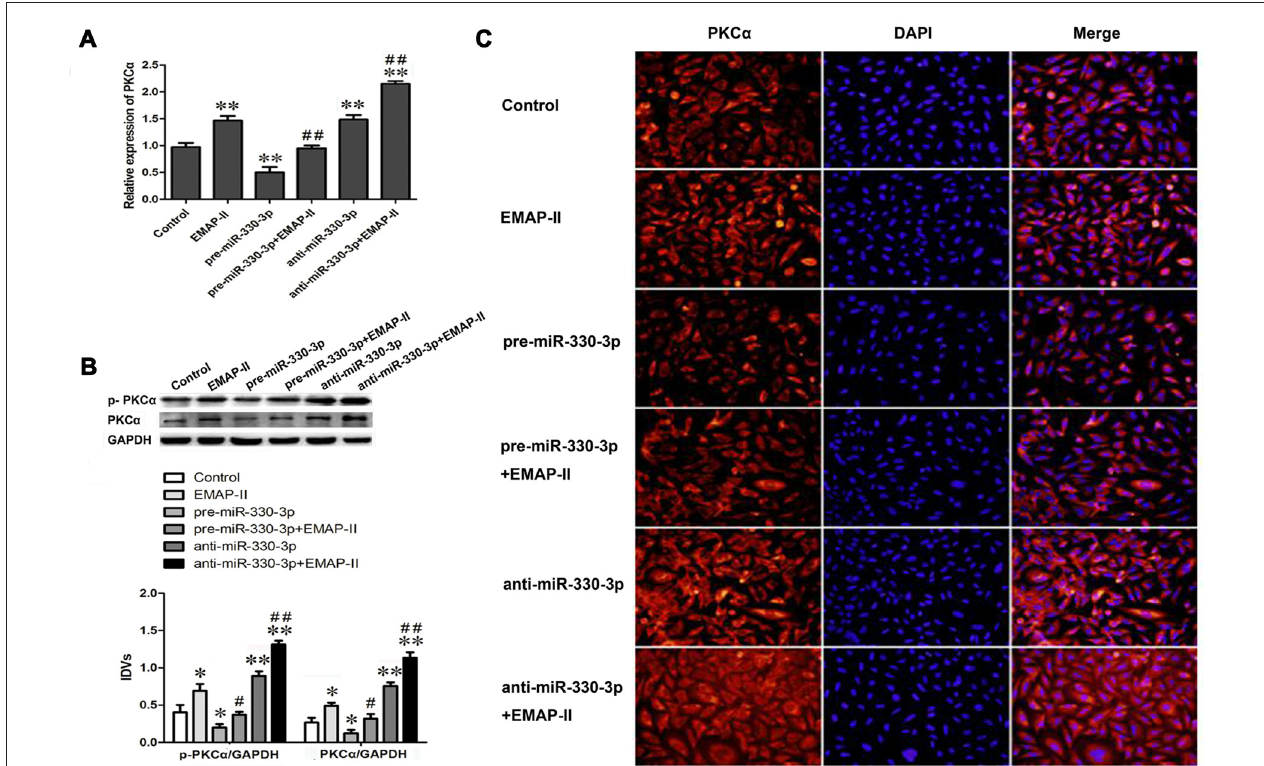
FIGURE 4 | Effects of overexpression or silencing of miR-330-3p on the expression levels of PKC α and p-PKC α in EMAP-II treated GECs. (A) The relative mRNA expression level of PKC α was detected by real-time quantitative PCR. U6 was used as an inner control. (B) Western blot analysis of the PKC α and p-PKC α levels in GECs. GAPDH was used as an inner control. ∗ P < 0.05, ∗∗ P < 0.01 vs. control group; # P < 0.05, ## P < 0.01 vs. EMAP-II group. (C) The expression and distribution of PKC α in GECs was analyzed by immunofluorescence assay. Scale bar represents 20 µ m. Values are means ± SD ( n = 5,